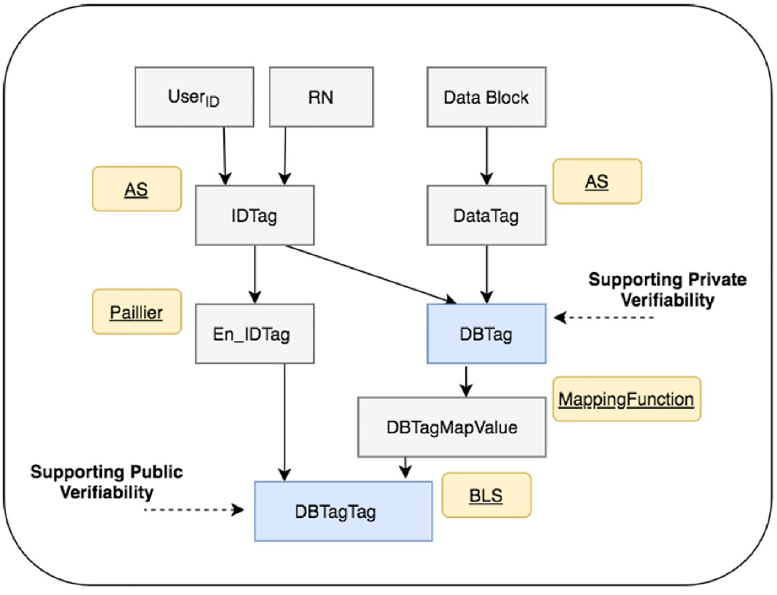
BLS-AggSigV algorithm : Given an aggregated signature, i.e. AggDBSig , a public